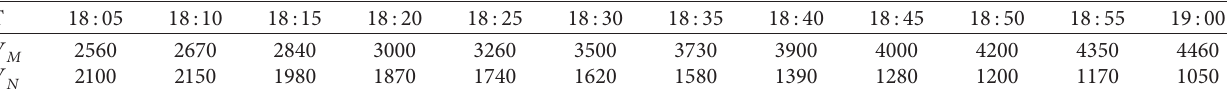
Table 2: Traffic flow data.